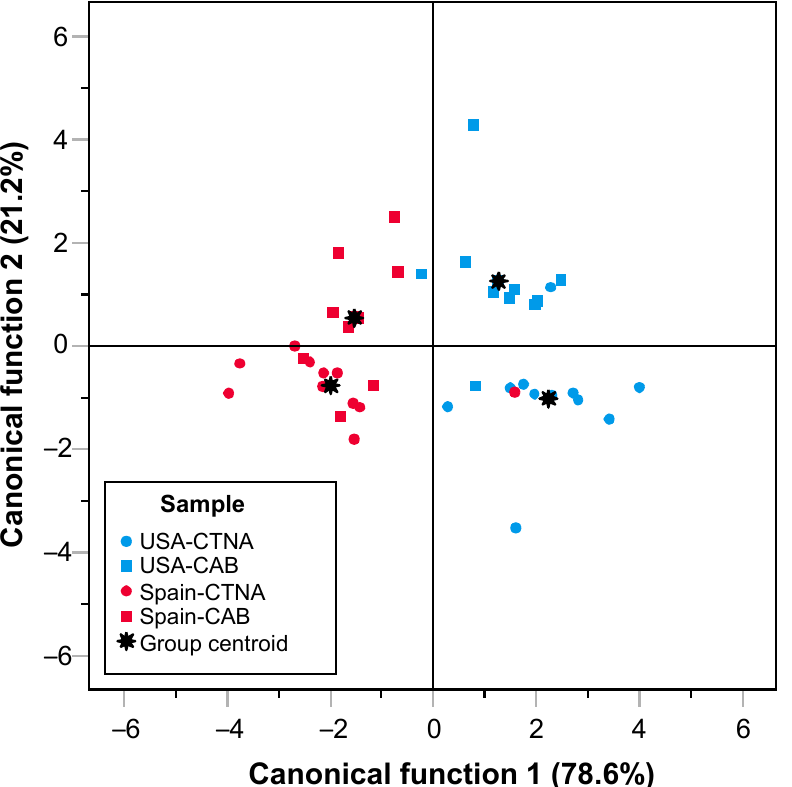
Figure 2. Spatial location of the PGI-Certified Ternera de Navarra ( CTNA ) and Certified Angus Beef ( CAB ) samples according to common attributes assessed in the USA (UIUC) and Spain (UPNA). Function 1 (texture factor) was associated with tenderness and juiciness, and function 2 (flavor factor) was associated with beef flavor.